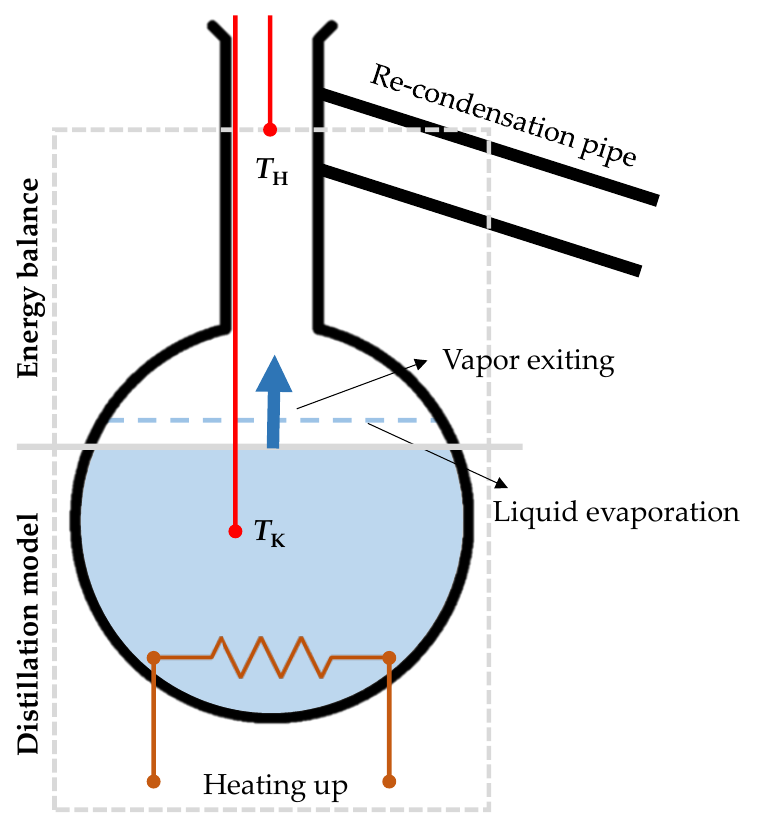
Figure 1. Sketch of the experimental distillation process . Gray squares represent the areas of interest of the modeling steps.